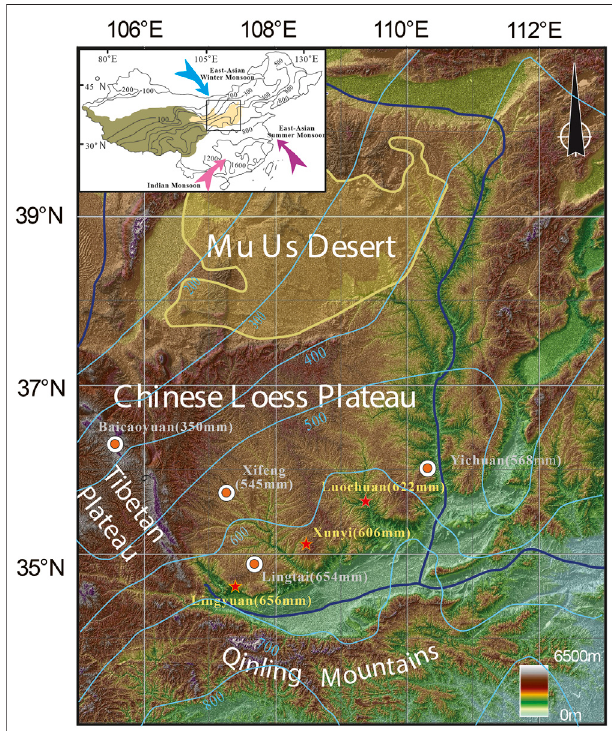
FIGURE 1 | Chinese Loess Plateau, prevailing monsoon circulation, and model precipitation gradients. Solid red stars show locations of three sites investigatedinthisstudy,andblackcirclesdenotelocationsofsitespreviously studied (Zhu et al., 2004; Zhang et al., 2010).